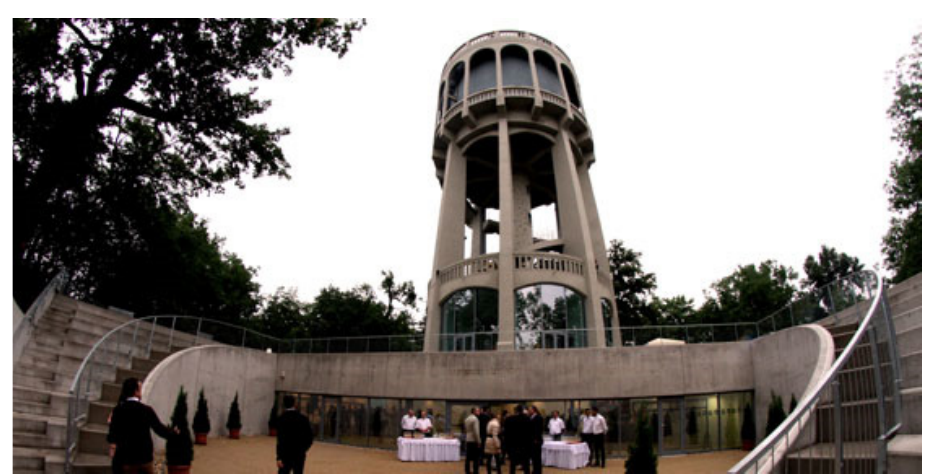
Figure 13. Renovated Water Tower. Source: own collection.